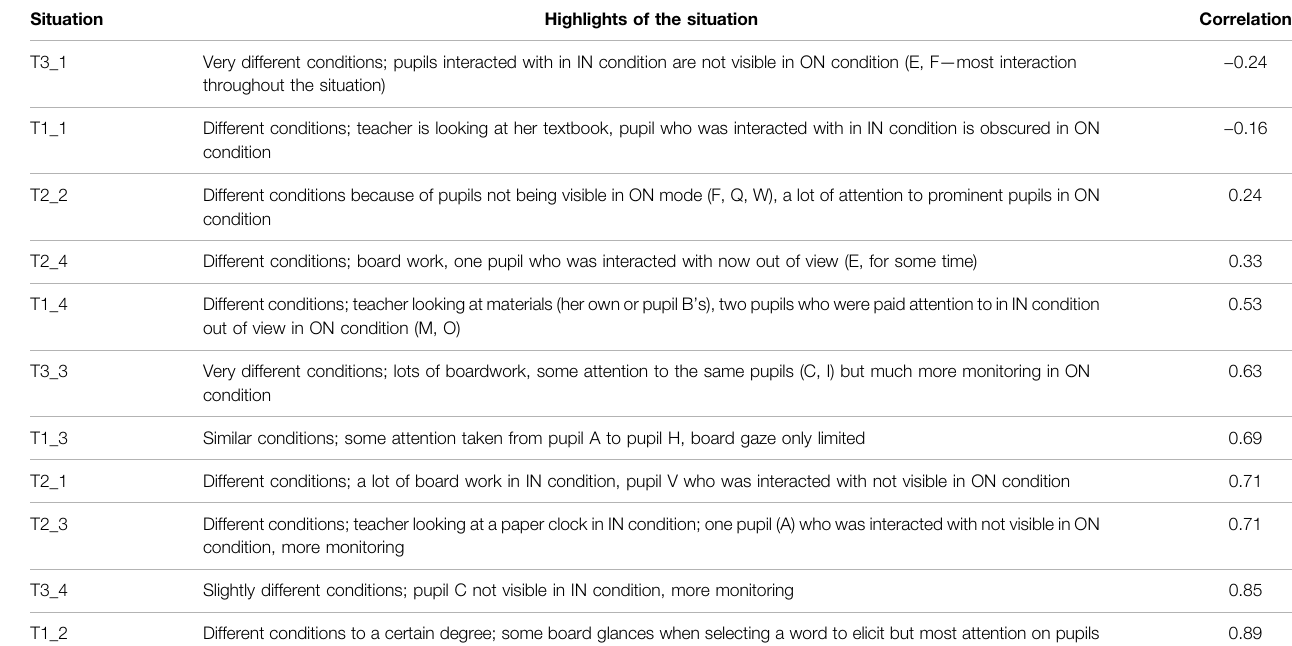
TABLE 4 | Correlations between dwell time per pupil in IN and ON conditions. Situation Highlights of the situation